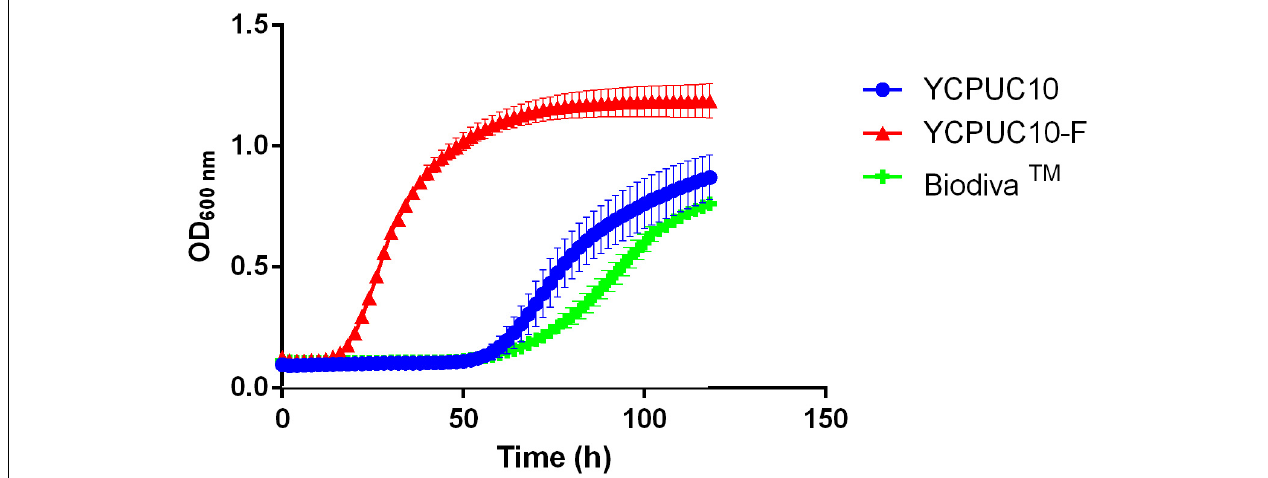
FIGURE 4 | Growth curves of T. delbrueckii YCPUC10, YCPUC10-F and commercial strain Biodiva TM , in synthetic must with 50 mg/L of free SO 2 . Means ± SD ( n = 3).